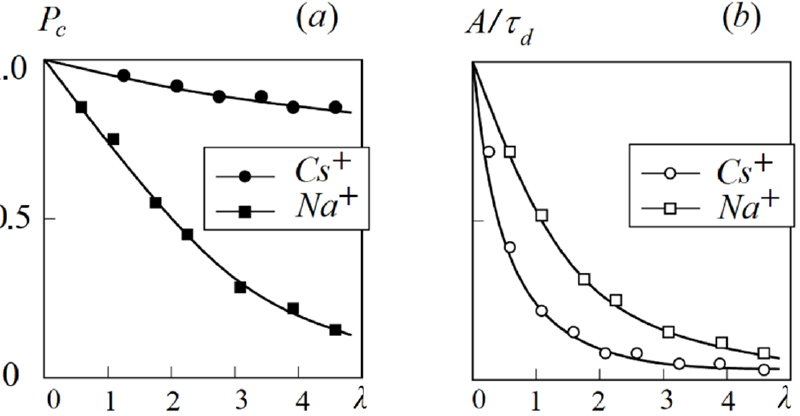
Figure 13. ( a ) Relative part of contact ionic pairs P c of Na + SO 3 − and Cs + SO 3 − ; ( b ) relative translational mobility frequency A / τ d of Na + and Cs + cation humidity dependences in the perfluorinated sulfo cation-exchange membrane MF-4SC [105].